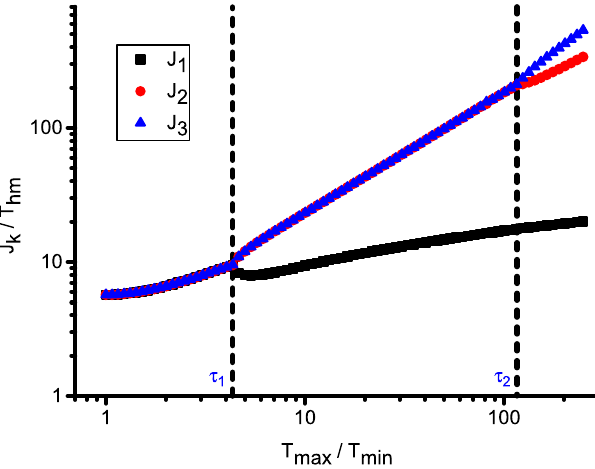
Fig. 3 Optimal probe for the non-uniform XXX Hamiltonian. Optimal coupling parameters J k within the k th dimer ( k = 1,2,3) against temperature ratio T max = T min for an optimized H XXX (reduced to an dimerized chain) for n = 6 spins. The coupling parameters are scaled with the characteristic temperature T hm , where T hm is the harmonic mean of T min and T max . The dashed lines indicate the onset of the splitting of optimal